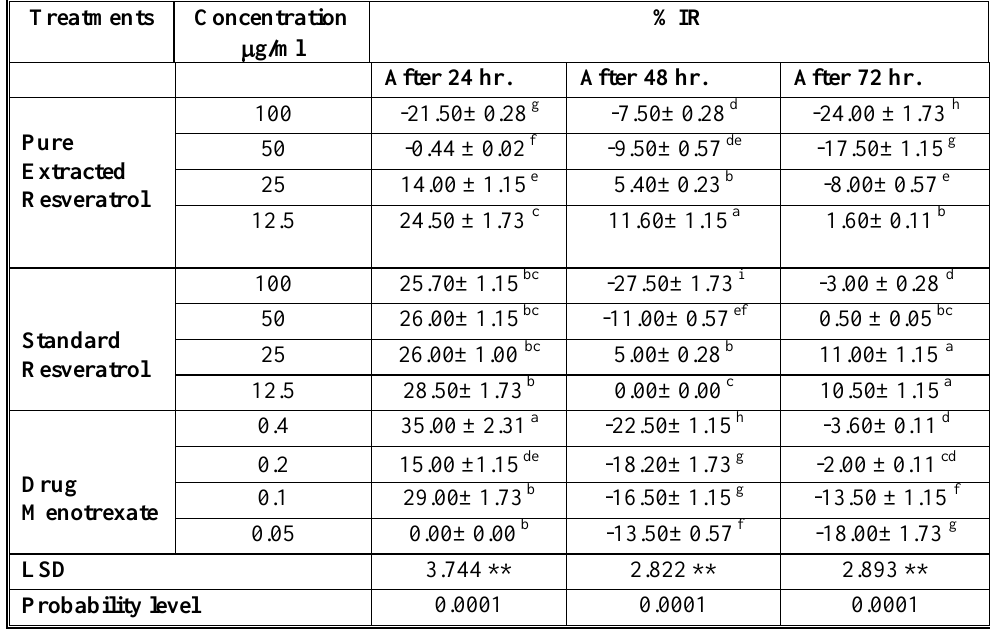
Table 2: The cytotoxic effect as inhibition rate percent (%IR) of extracted pure resveratrol and trans- resveratrol standard and methotrexate drug on Hep-2 cell line at (24,48 and 72) hours of